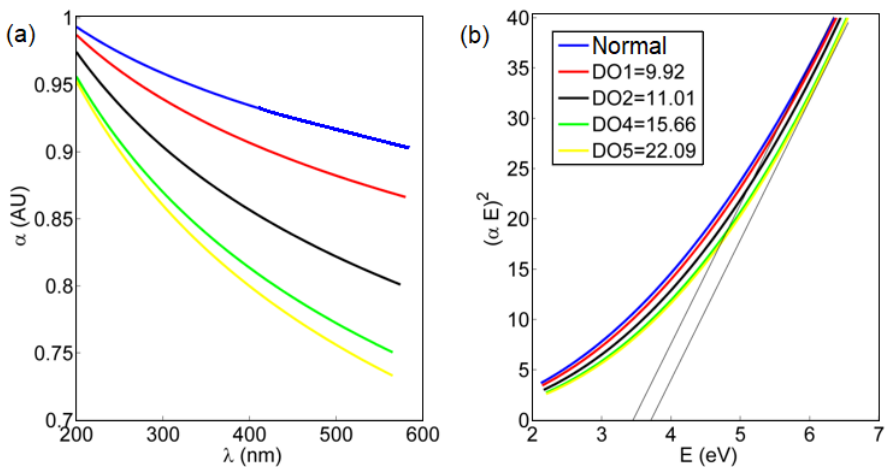
Figure 4. ( a ) Absorbance dispersion; and ( b ) bandgap calculations for gold-ceria NPs with different added DO concentrations. Normal means the default DO concentration in distilled water with no further added oxygen, which was measured to be 7.8 mg/L. All mentioned DO concentrations are in units of mg/L. Legend box is common for both Figure 4a,b.